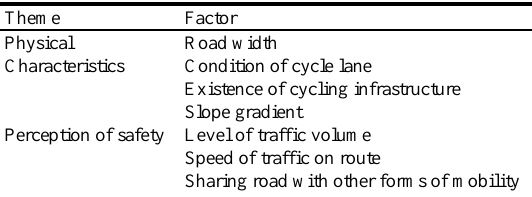
Table 1. Factors influencing cycling trips in Johannesburg.